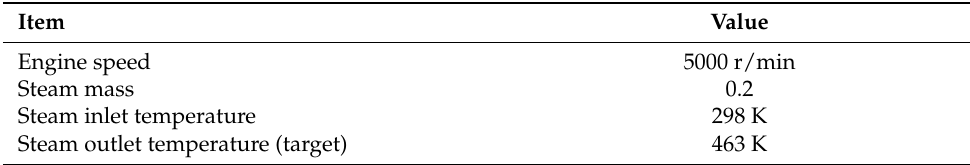
Table 3. Input parameters of the heat exchanger design. Item Value Engine speed 5000 r/min Steam mass 0.2 Steam inlet temperature 298 K Steam outlet temperature (target) 463